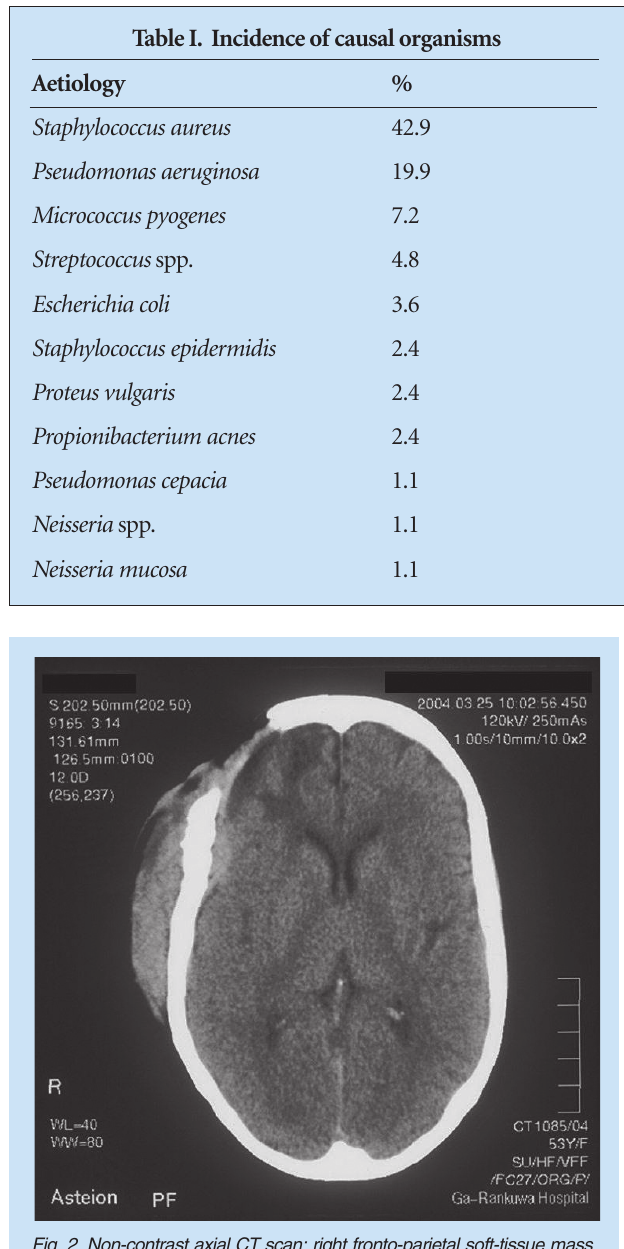
Fig. 2. Non-contrast axial CT scan: right fronto-parietal soft-tissue mass, with an intracranial component. The scan also confirmed the bone defect.